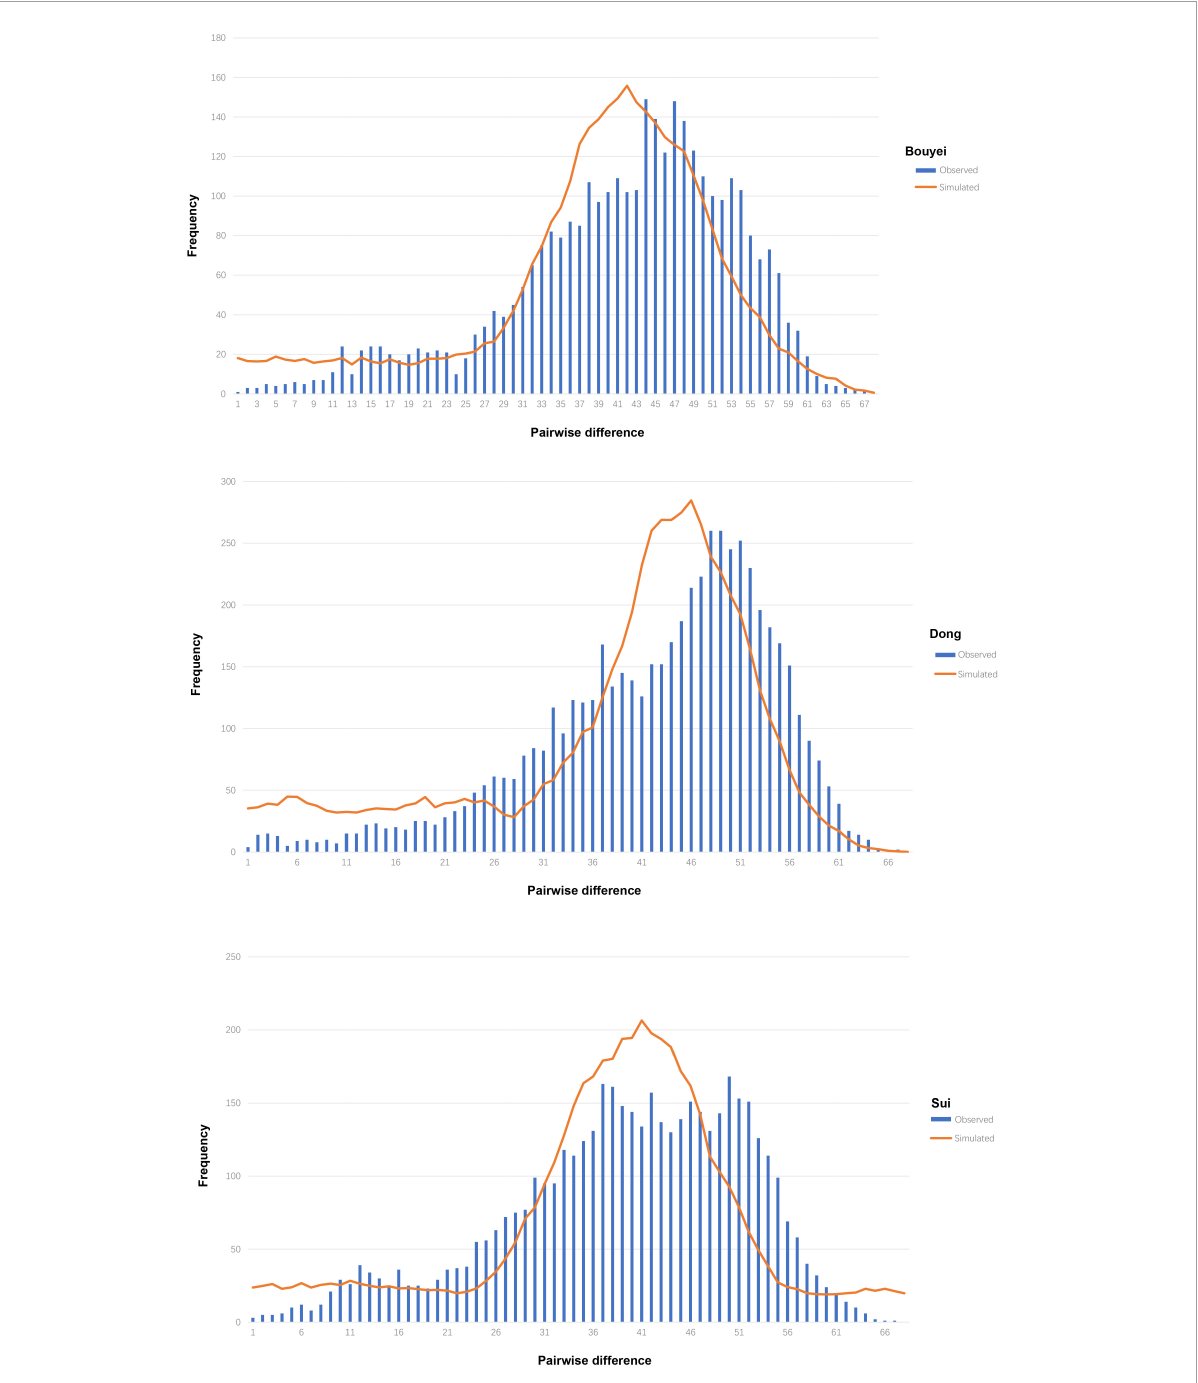
FIGURE2 Mismatch distribution of three Tai-Kadai-speaking populations in Guizhou. The orange solid line represents the simulated model, and the blue bar graph represents the observed model of the Tai-Kadai-speaking populations in Guizhou.